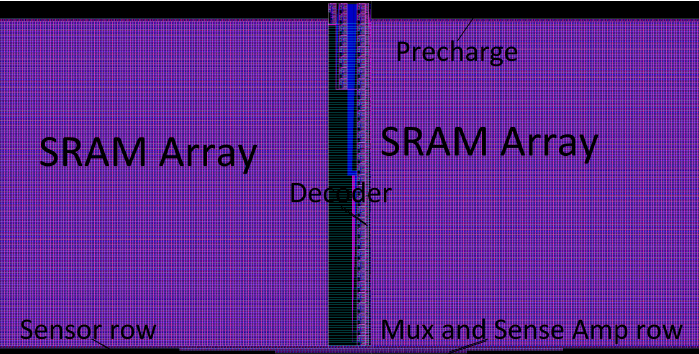
Figure 14. Butterfly architecture based without IO-pad SRAM microchip.